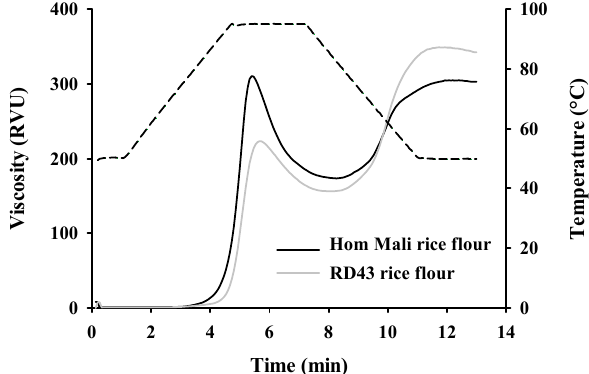
Figure 4. Pasting properties pattern of Hom Mali and RD43 rice flour .